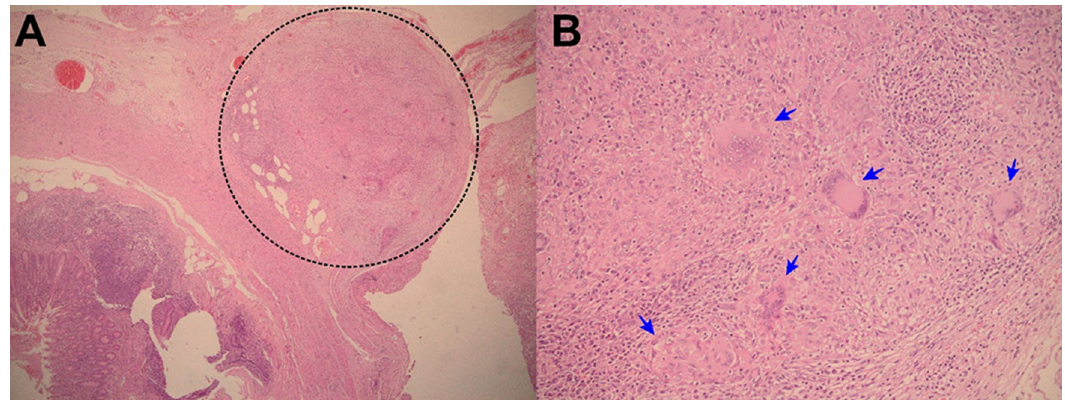
Figure 1. A: Electronic microphotography (x40) showing chronic granulomatous mesoappendicitis and a pseudotumoral lesion which corresponds to granulomas (circle in dotted line). B: Electronic microphotogra- phy (x40) showing Langhans multinucleated giant cells inside the granuloma (blue arrows). No caseous necrosis was seen. Ziehl-Neelsen smear for Acid Fast Bacilli was